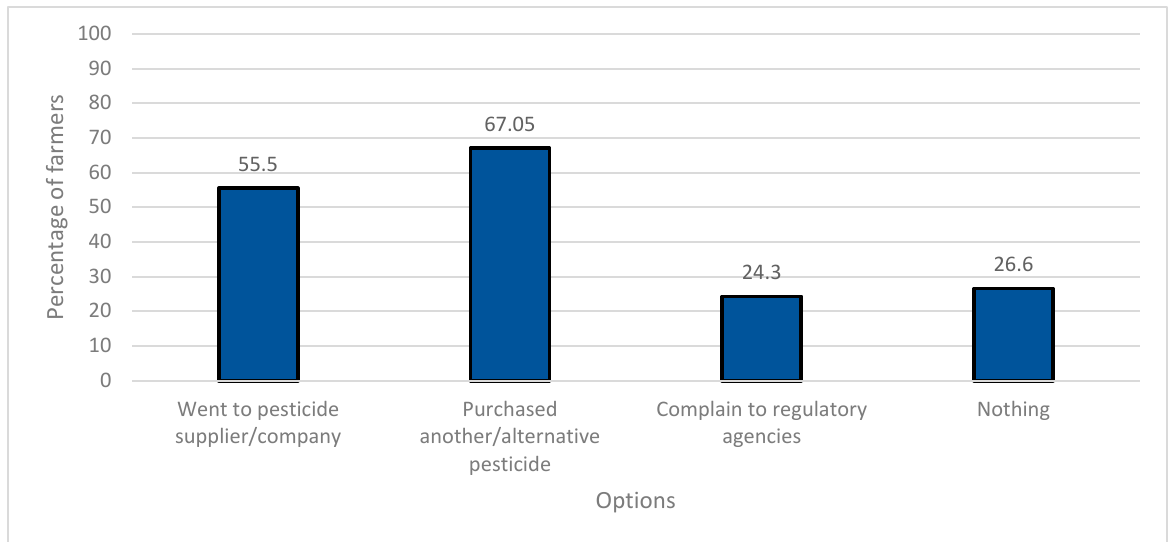
Figure 2. Behavior after discovering fraudulent pesticides (by the farmers who purchased fraudulent pesticides).